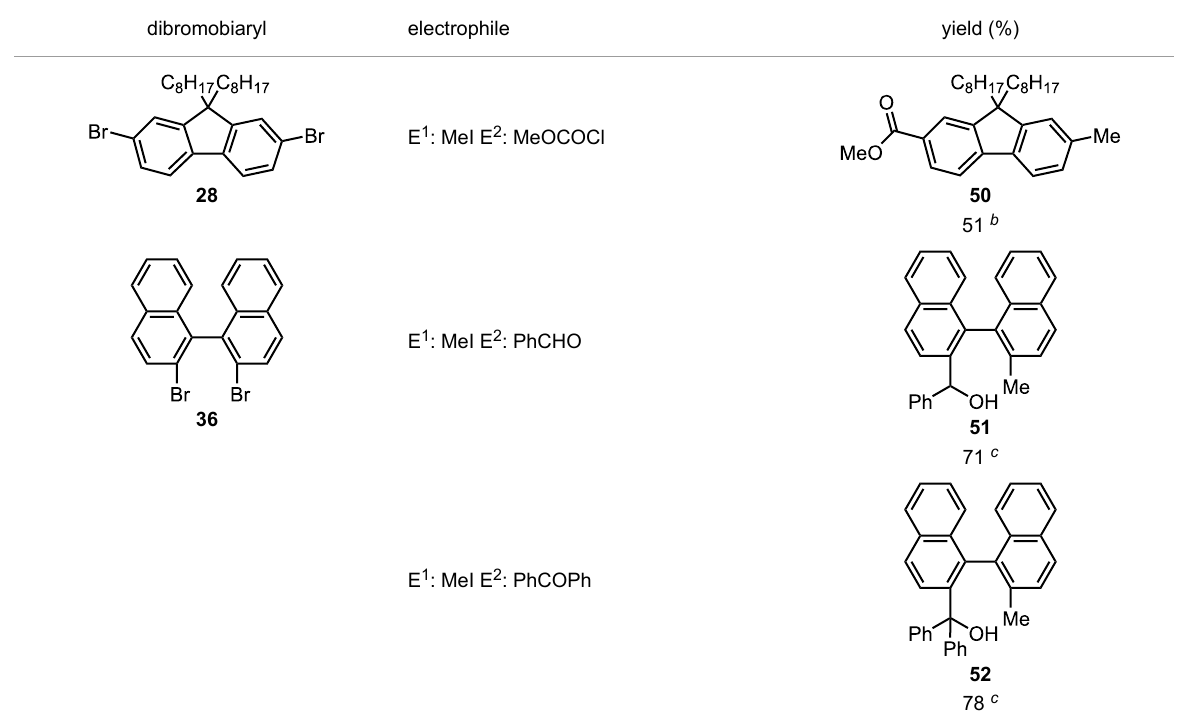
Table 9: Synthesis of unsymmetrially substituted biaryls from dibromobiaryls by sequential introduction of two electrophiles. a dibromobiaryl